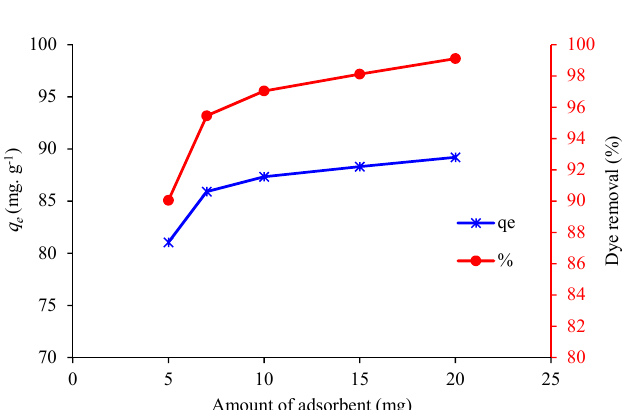
Fig. 8: Effect of adsorbent dosage on MB dye adsorption by Fe